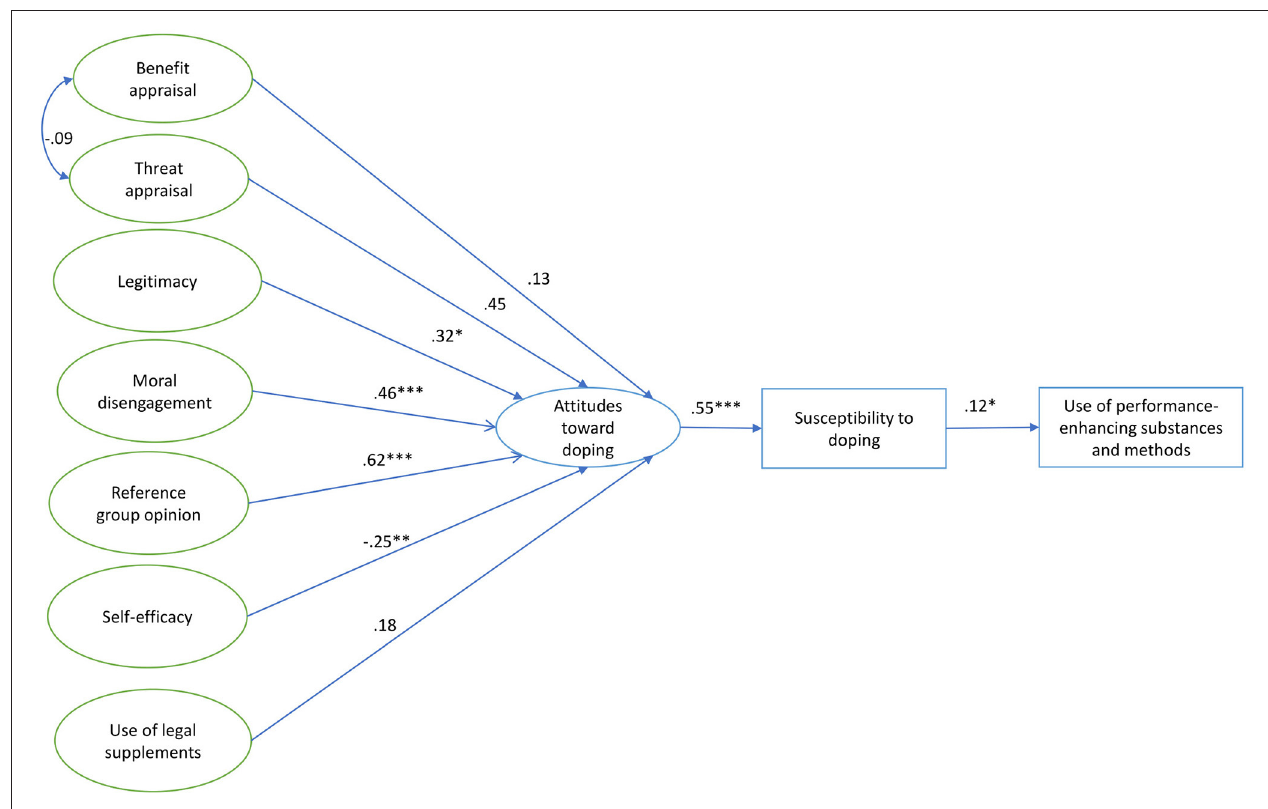
FIGURE 1 | Overview of results of structural equation model analysis with standardized parameter estimates. Different levels of significance according to p -value: * p < 0.05, ** p < 0.01, and *** p < 0.001.